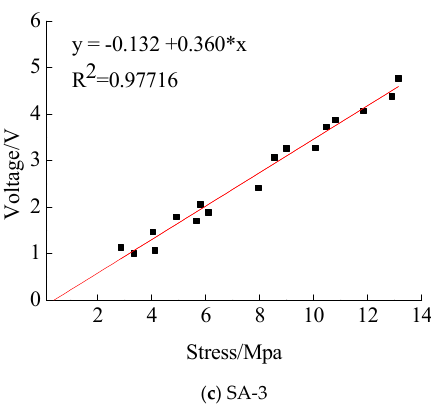
Figure 7. The calibration results of piezoceramic smart aggregates.